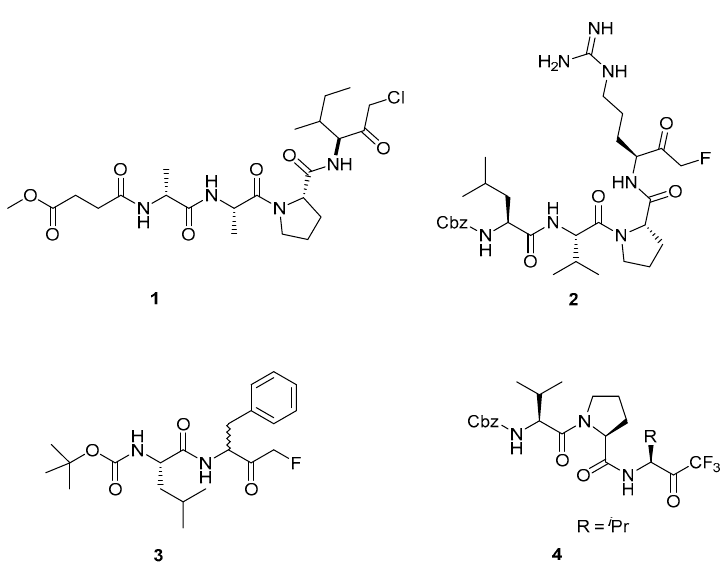
Figure 1. Representative examples of a peptidyl chloromethyl ketone ( 1 ) [12], peptidyl fluoromethyl ketones ( 2 [3] and 3 [2]), and a peptidyl tri-fluoromethyl ketone ( 4 ) [15].